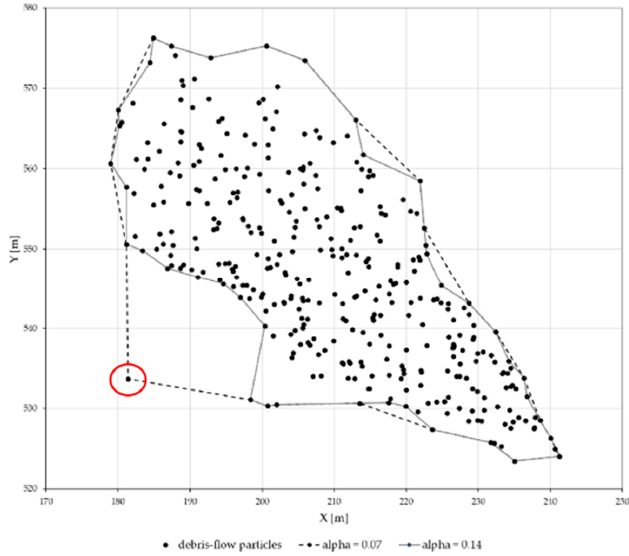
Figure A1. The α -shape with alpha = 0.07 includes an outlier point, while alpha = 0.14 does not include an outlier point. The debris-flow particle, which is considered as outliers, is indicated by a red circle.